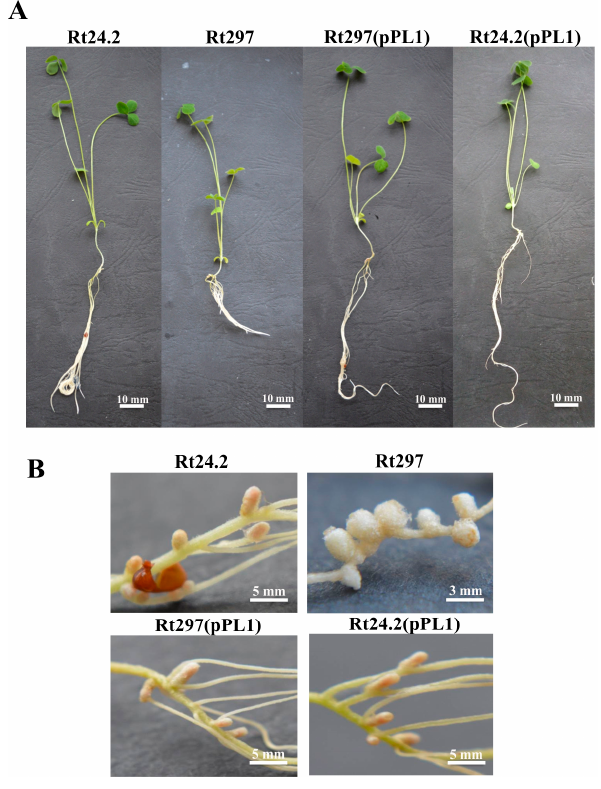
Figure 11. Clover plants at 28 dpi with the wild-type strain R. leguminosarum Rt24.2 and its derivatives ( A ) and nodules elicited on their roots by these strains ( B ).